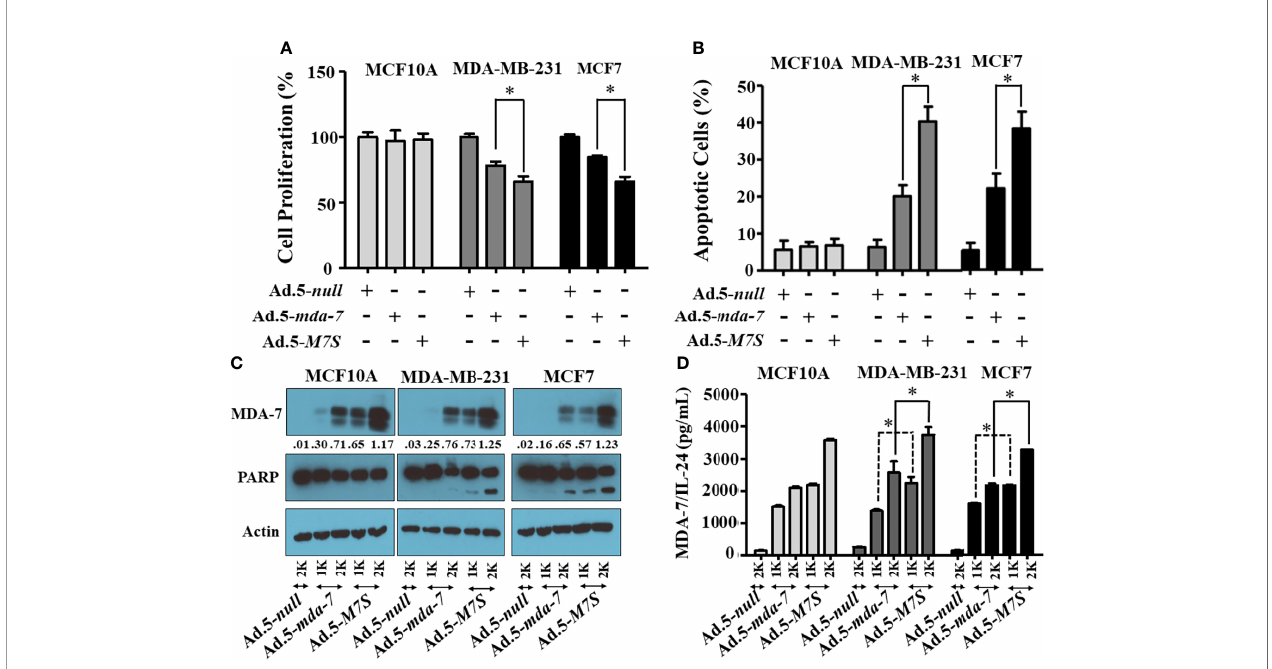
FIGURE 4 | Ad.5- M7S suppresses proliferation and induces apoptosis of breast cancer cells more robustly than wild type Ad.5- mda-7/IL-24 . A & B) Indicated cells were infected with Ads expressing either mda-7/IL-24 or M7S ( IL-24S ) at different m.o.i. After 72 hr., cell proliferation (A) and apoptosis (B) were determined by MTT assay and Flow-cytometry (Annexin-V/PI- staining), respectively. (C) Western blotting analysis was performed to determine intracellular MDA-7/IL-24 protein levels and PARP cleavage. Actin was used as a loading control. Values underneath the blot represent fold-changes in densitometry for MDA-7/IL-24 protein levels using